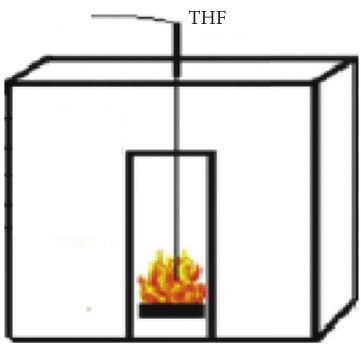
Figure 2: Device of confined tests.